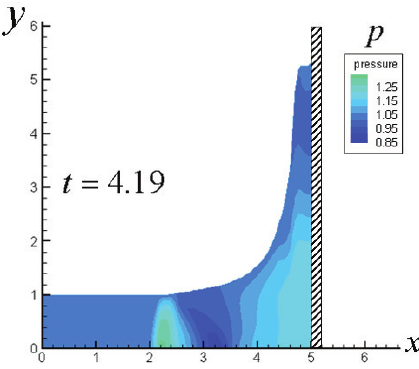
Figure 11. Pressure (divided by atmospheric pressure) in an avalanche after hitting a